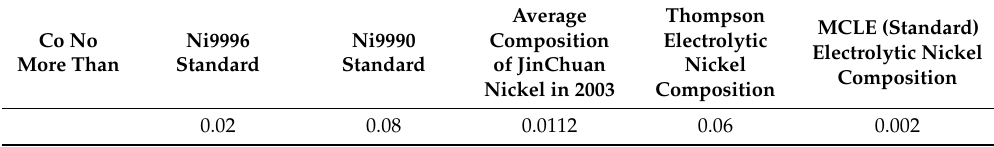
Table 6. Standard for cobalt content of electrolytic nickel